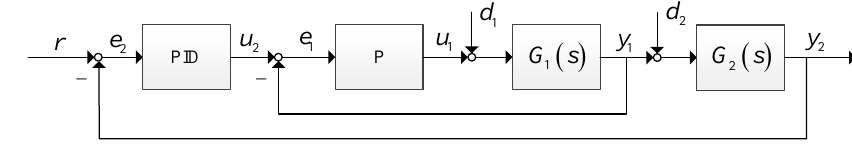
Figure 2. Cascade control structure.